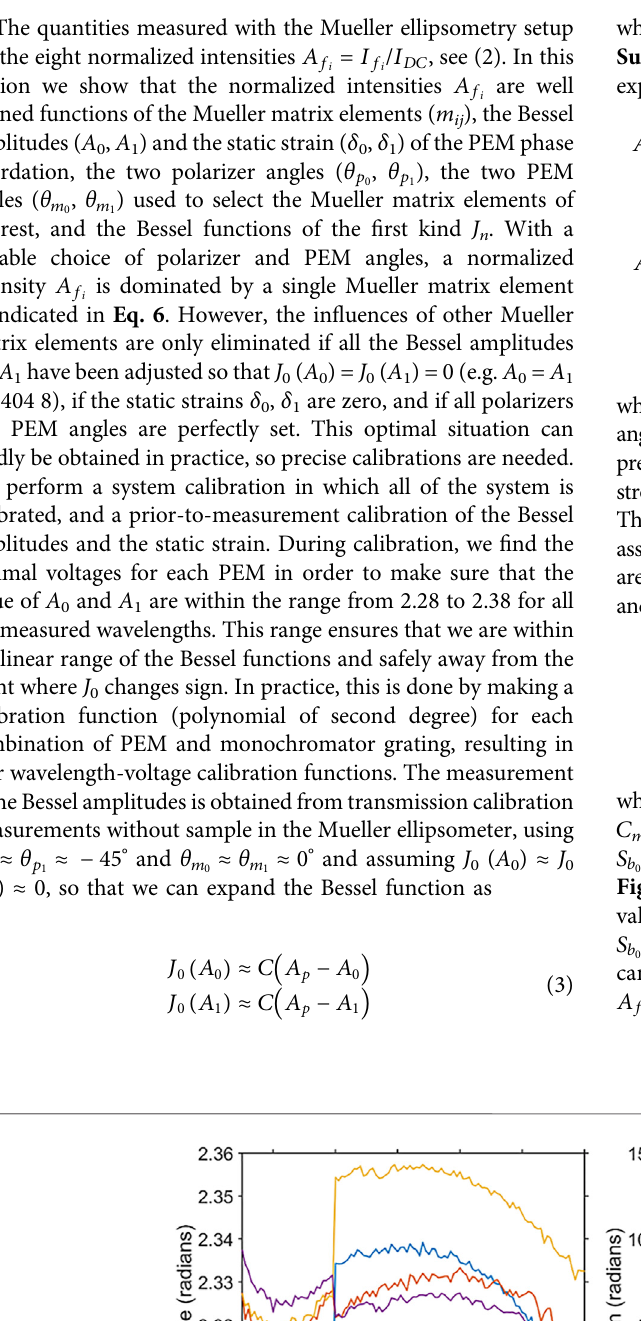
Frontiers in Physics |